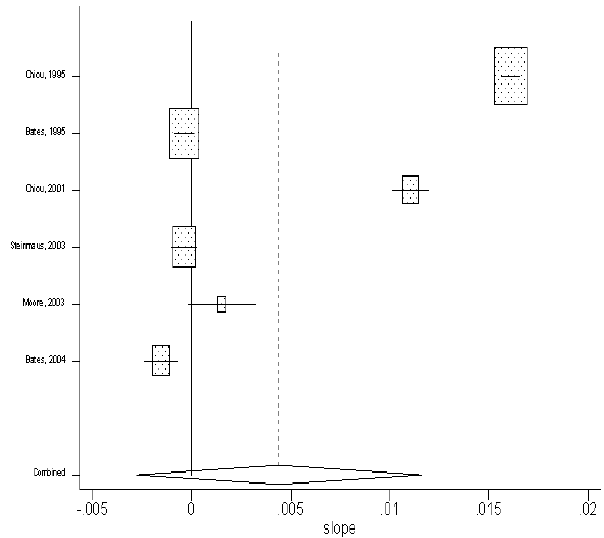
Figure 3: Slope (with the unit of lnRR per unit increase of exposure) of each study and the combined estimate of slope by using random-effect model.